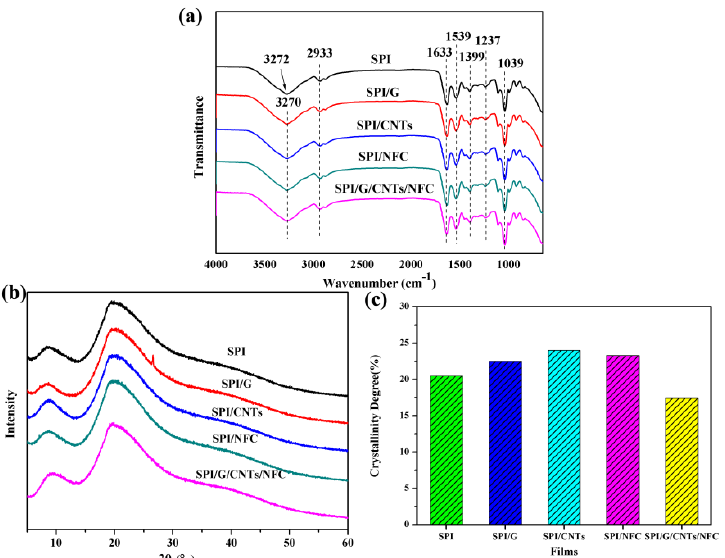
Figure 2. ( a ) Attenuated total reflectance – Fourier transform infrared (ATR – FTIR) spectra, ( b ) X-ray diffraction patterns, and ( c ) crystallinity parameters of SPI film and SPI-based